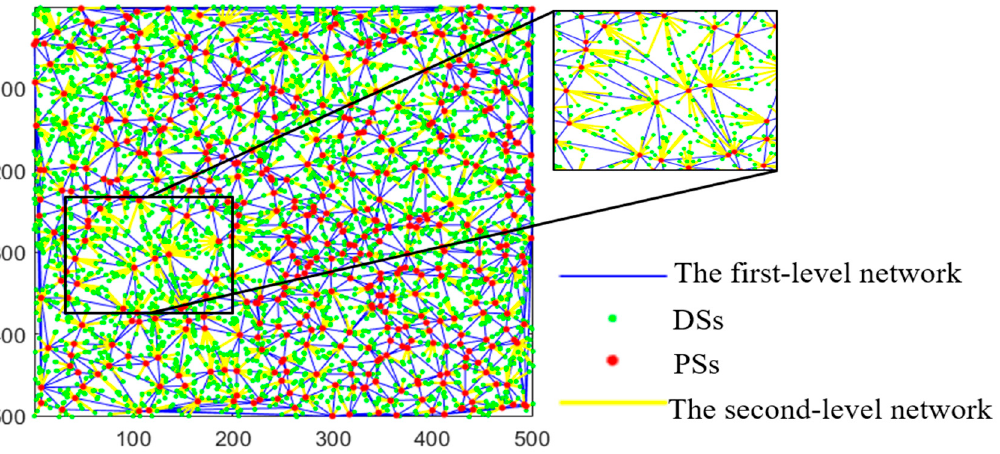
Figure 5. The proposed two-level network combining PSs and DSs.